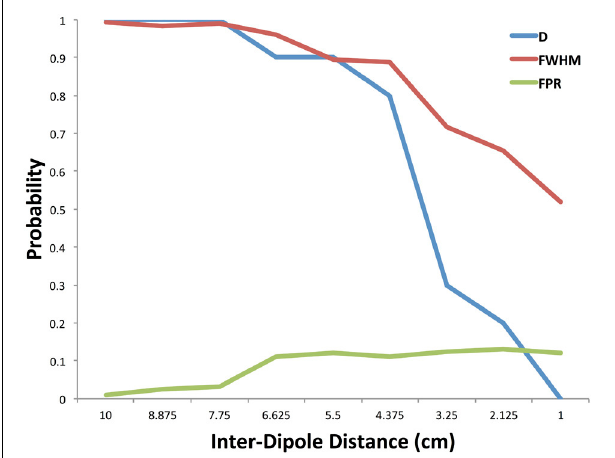
FIGURE 5 | Method performance in simulation. The probability of the cluster containing the dipole being significantly connected is plotted with the probability that at least one cluster within the FWHM was significantly connected. These are plotted as a function of the distance between the two original dipoles used in generating the simulation. In addition, the false positive rate is shown for clusters significantly connecting outside the FWHM.